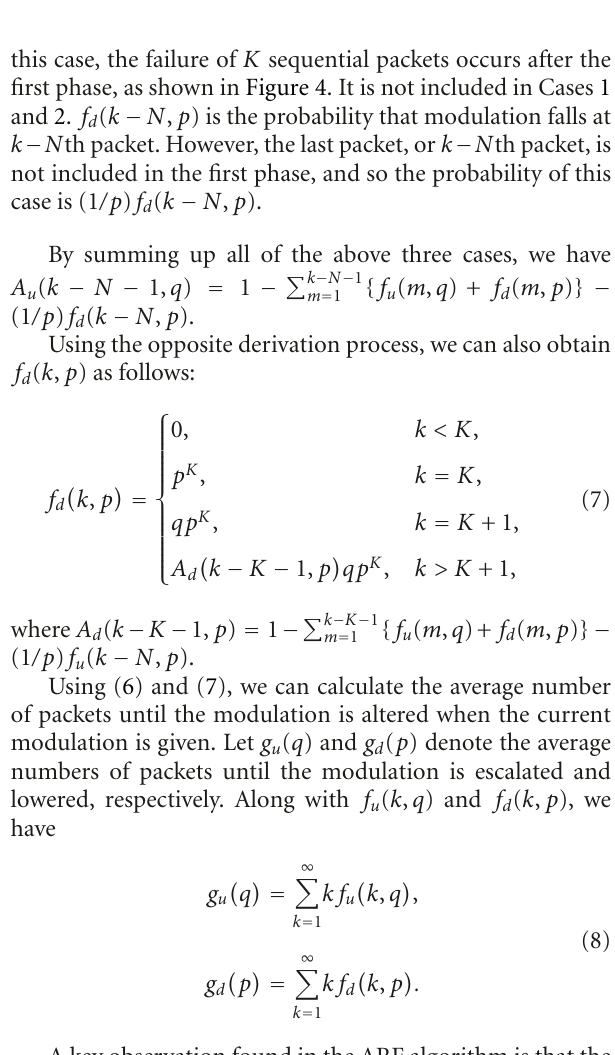
Figure 3: The case that the modulation is elevated after the transmission of k packets when k > N + 1.